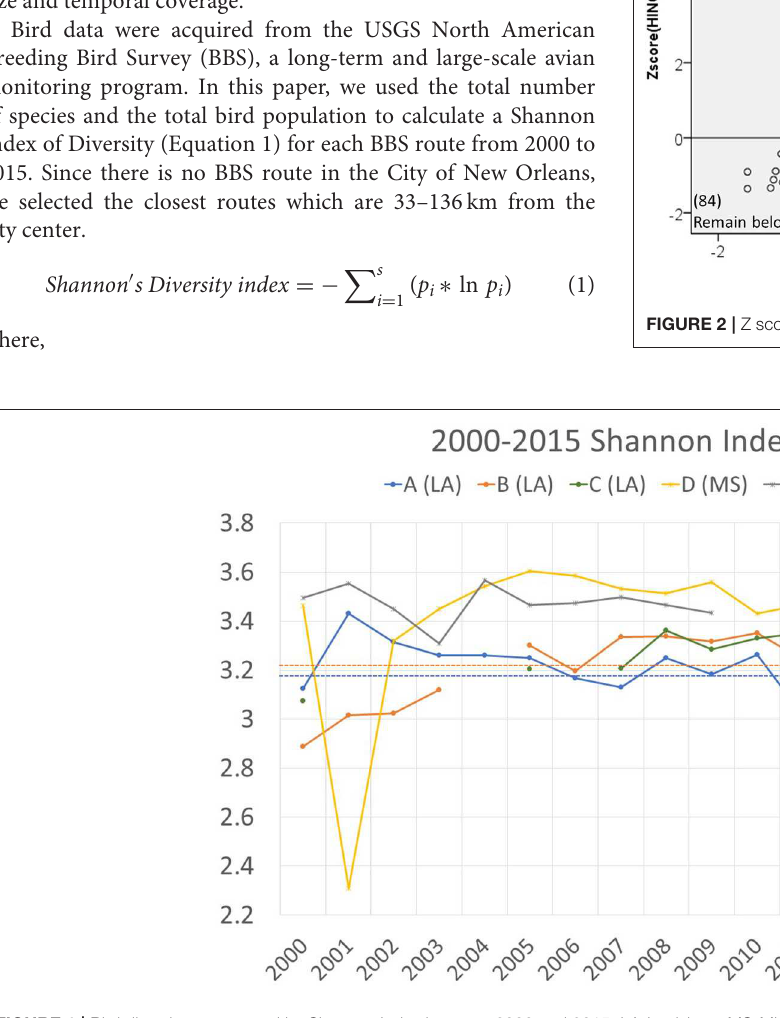
Frontiers in Environmental Science |